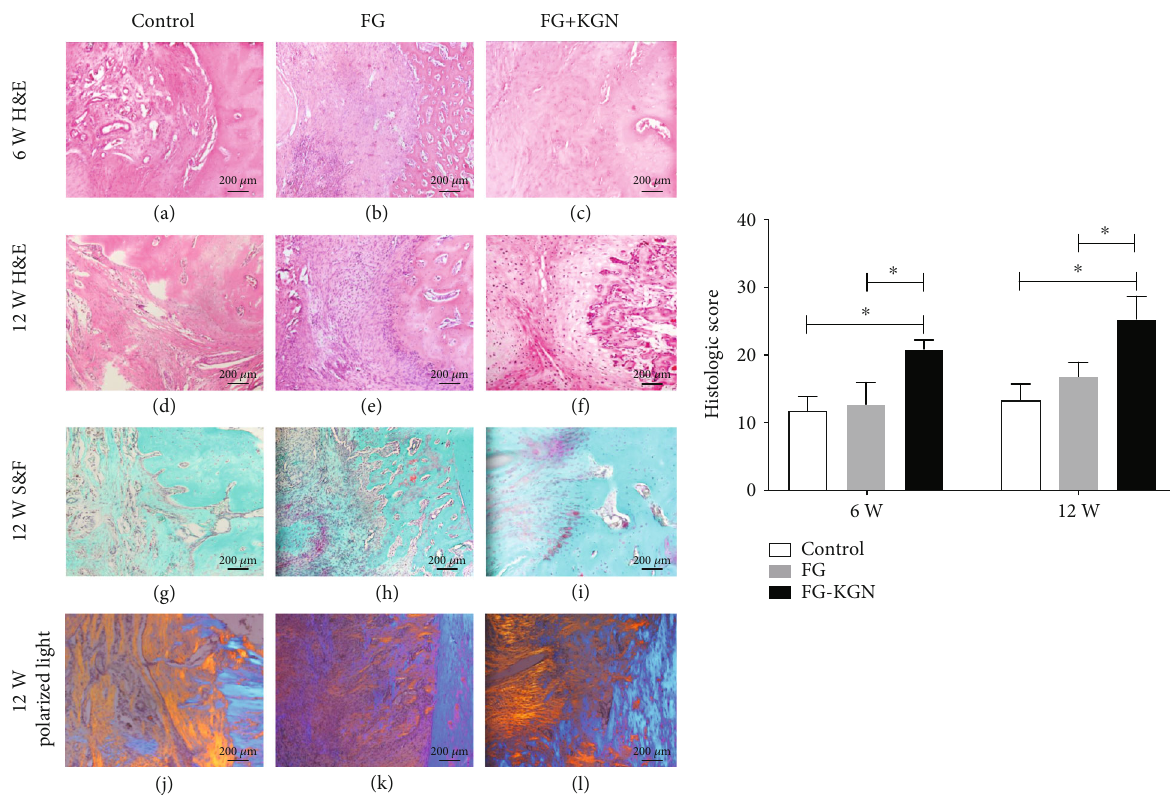
Figure 2: The tendon graft-bone interface healing at 6 and 12 weeks posttreatment. The tissue specimens were analyzed by HE staining (a – f), Safranin O/Fast green staining (g – i), and polarized light (j – l). At 6 and 12 weeks, the histological scores in the FG-KGN group were signi fi cantly higher than those in the control group and the FG group ( P < 0 : 01 ). Asterisks show a signi fi cant di ff erence between groups ( P < 0 : 01 ). Bar: 200 μ m.